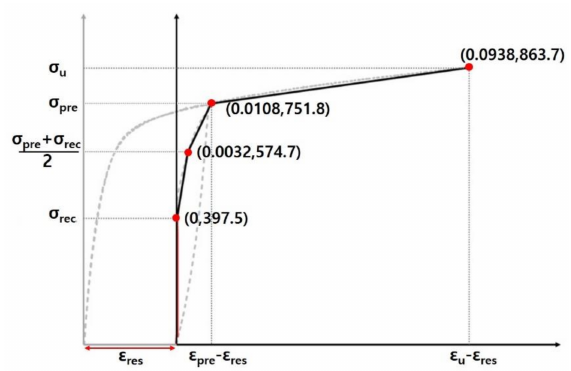
Figure 6. Constitutive model for Fe-SMA with recovery stress.